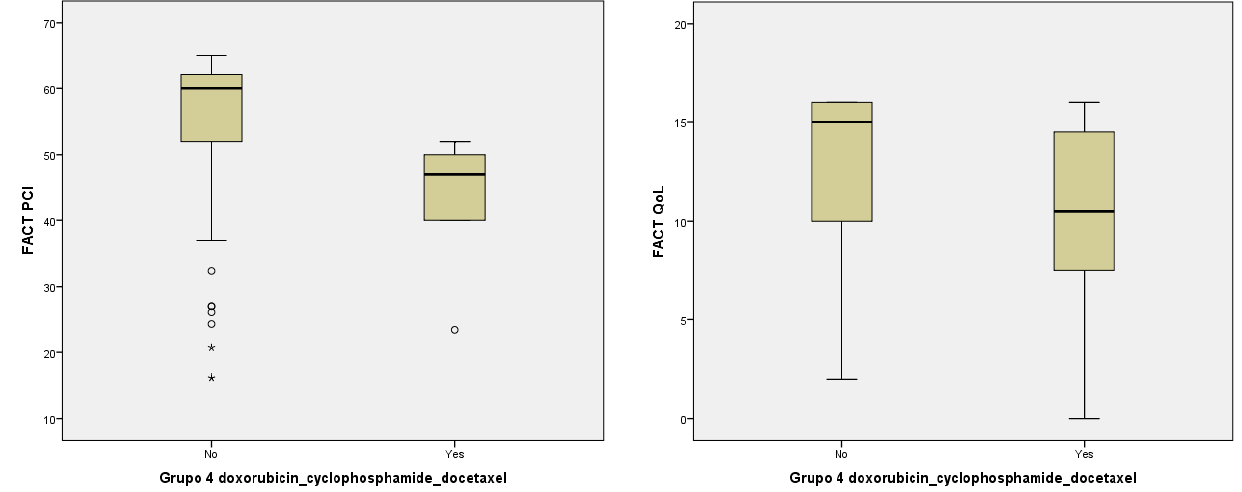
Figure 2. Relationship between PCI, QoL, and pharmacological group 4 (doxorubicin–cyclophosphamide–docetaxel).